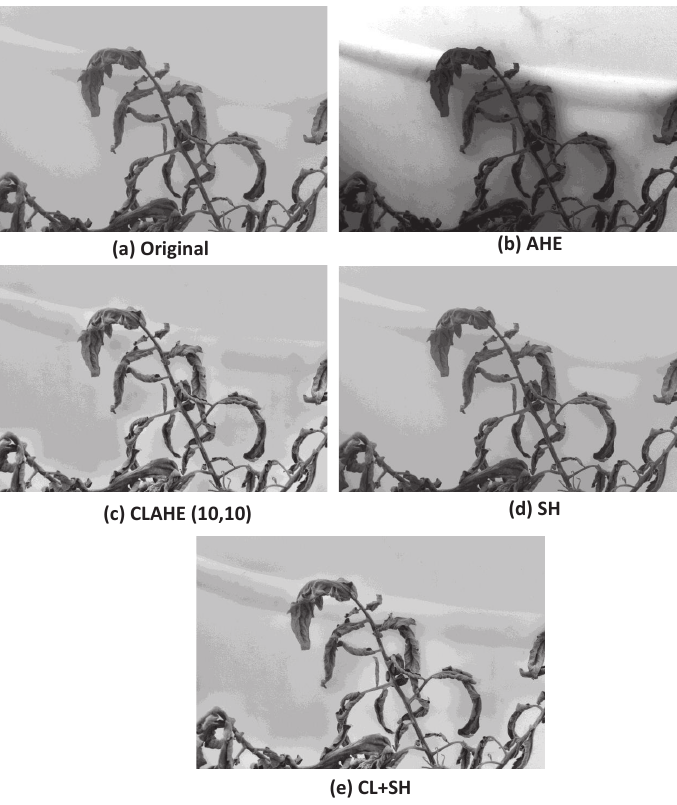
Figure 5. The output of the image preprocessing methods applied to a random image.